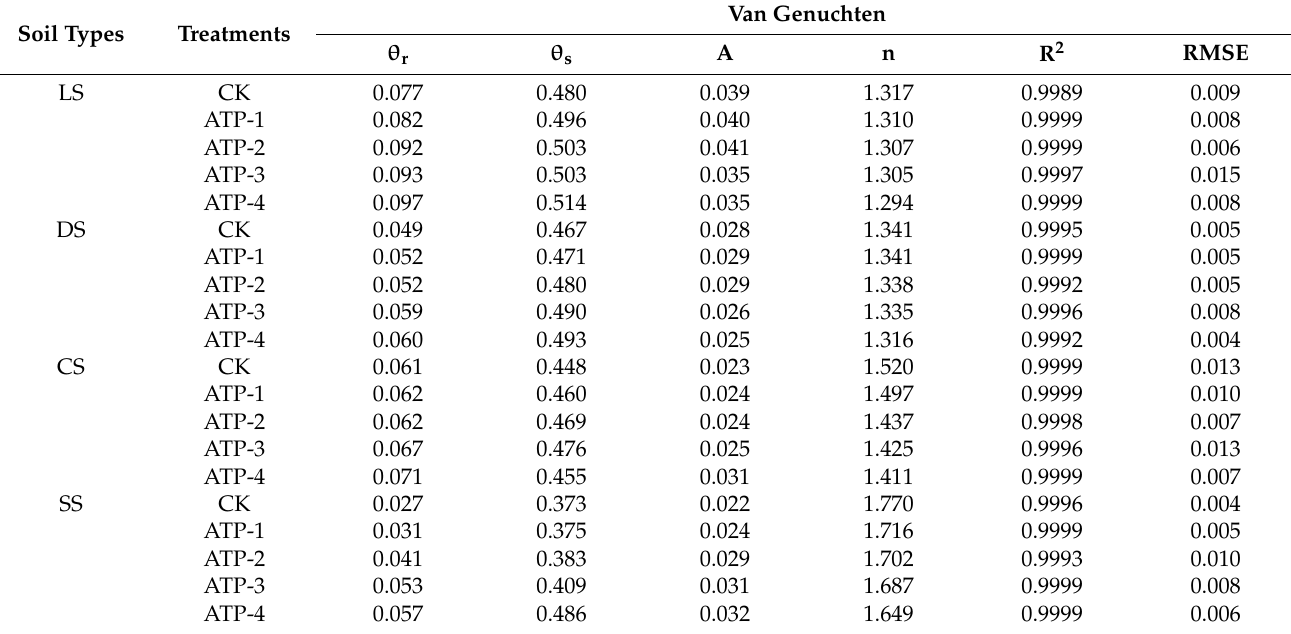
Table 3. Parameter fitting for the van Genuchten